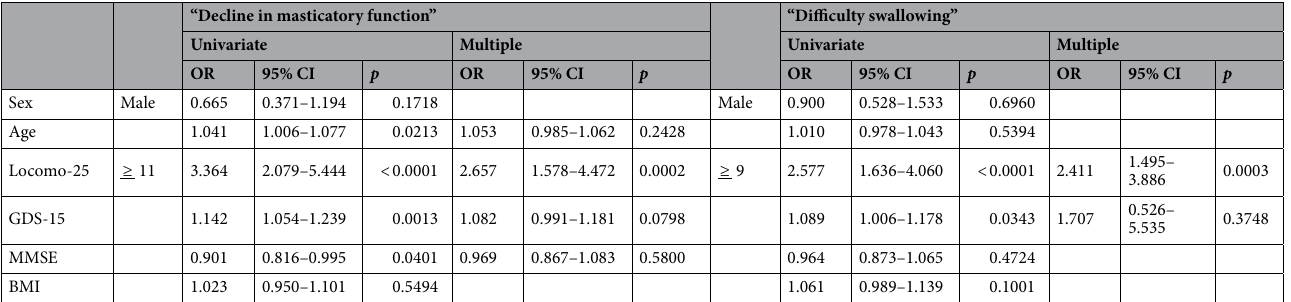
score of 11 points for discriminating “decline in masticatory function” (area under the curve (AUC) = 0.668, sensitivity = 48.96%, specificity = 77.81%, p < 0.0001) and 9 points for discriminating “difficulty swallowing” (AUC = 0.640, sensitivity = 50.47%, specificity = 71.67%, p = 0.0004) (Table 3).